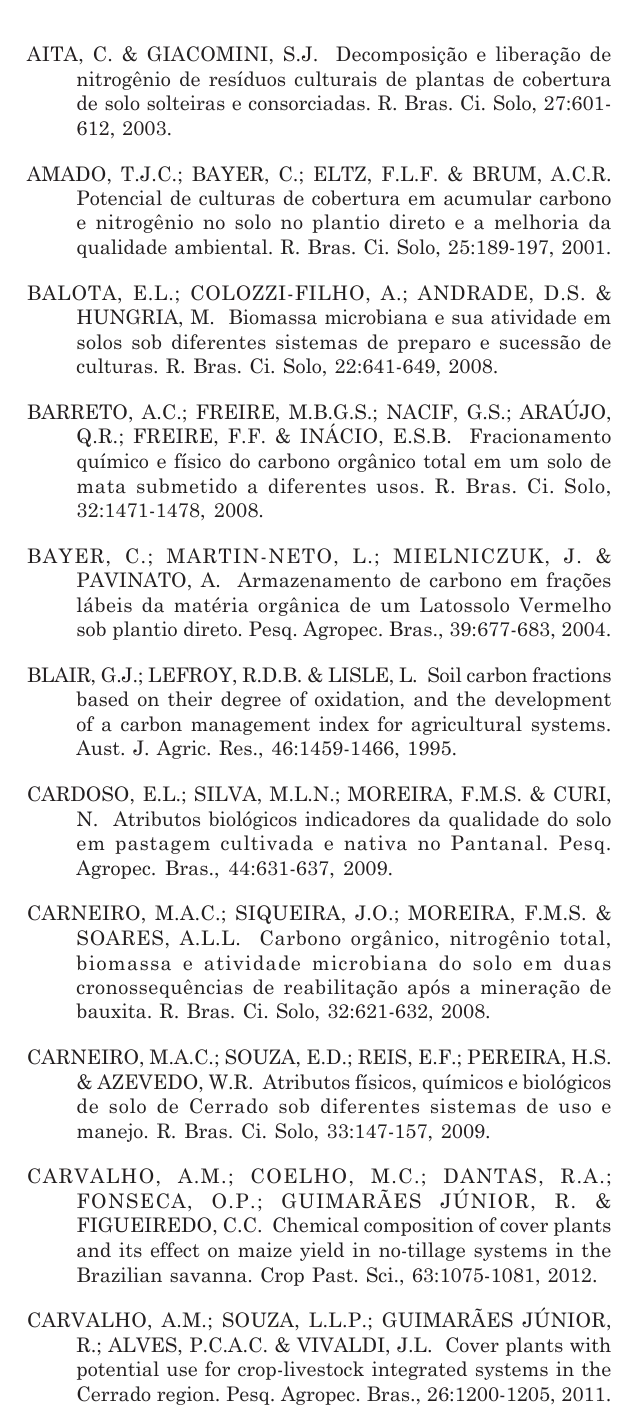
FIGUEIREDO, C.C. Chemical composition of cover plants and its effect on maize yield in no-tillage systems in the Brazilian savanna. Crop Past. Sci., 63:1075-1081, 2012. CARVALHO, A.M.; SOUZA, L.L.P.; GUIMARÃES JÚNIOR, R.; ALVES, P.C.A.C. & VIVALDI, J.L. Cover plants with potential use for crop-livestock integrated systems in the Cerrado region. Pesq. Agropec. Bras., 26:1200-1205, 2011.